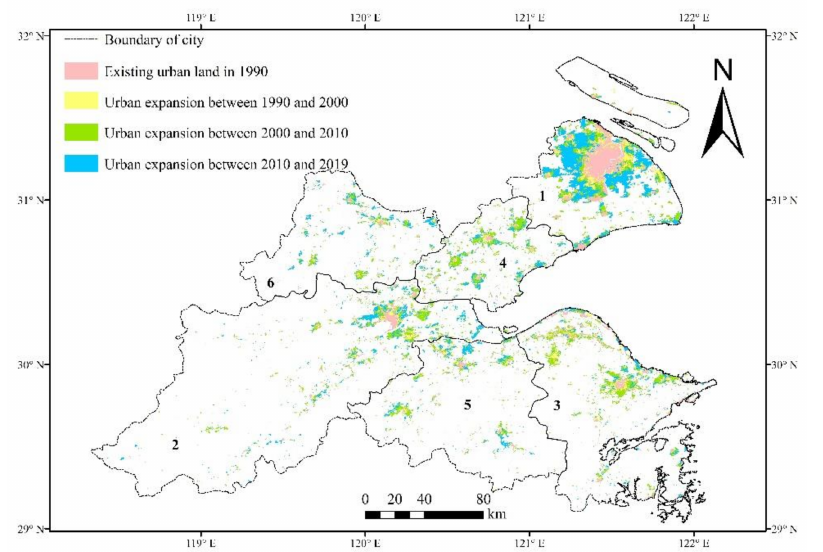
Figure 3. Spatial distributions of urban growth in SHB from 1990 to 2019: 1 Shanghai; 2 Hangzhou; 3 Ningbo; 4 Jiaxing; 5 Shaoxing; 6 Huzhou (the same